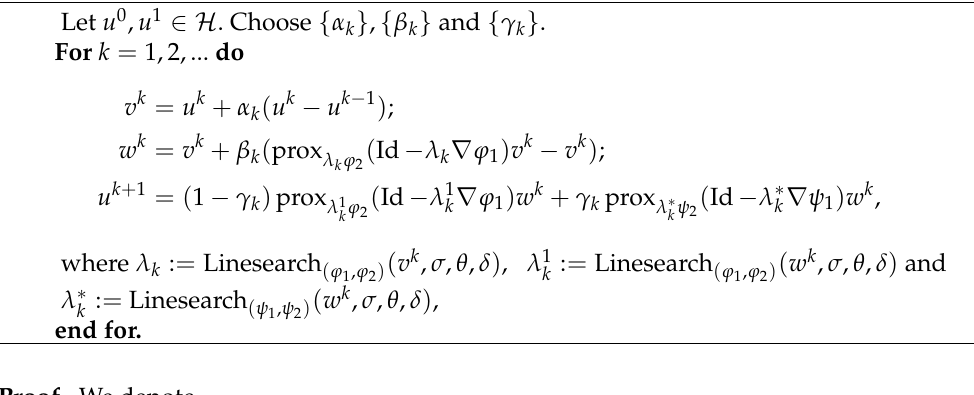
Algorithm 6 An inertial forward–backward splitting method with line search